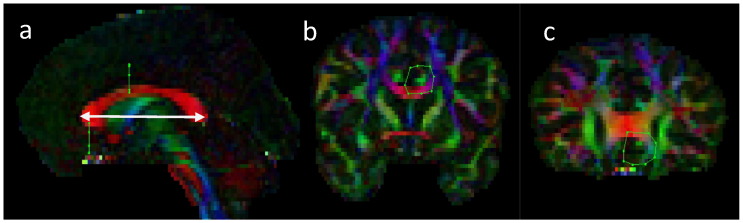
ROI placement for the subgenual cingulum. ROI placement for subgenual cingulum (left hemisphere): a) midsagittal plane — location of both ROIs, b) coronal plane — AND gate five slices anterior to the midpoint of the corpus callosum, c) coronal plane — AND gate three slices caudal to the anterior limit of the genu of the corpus callosum.